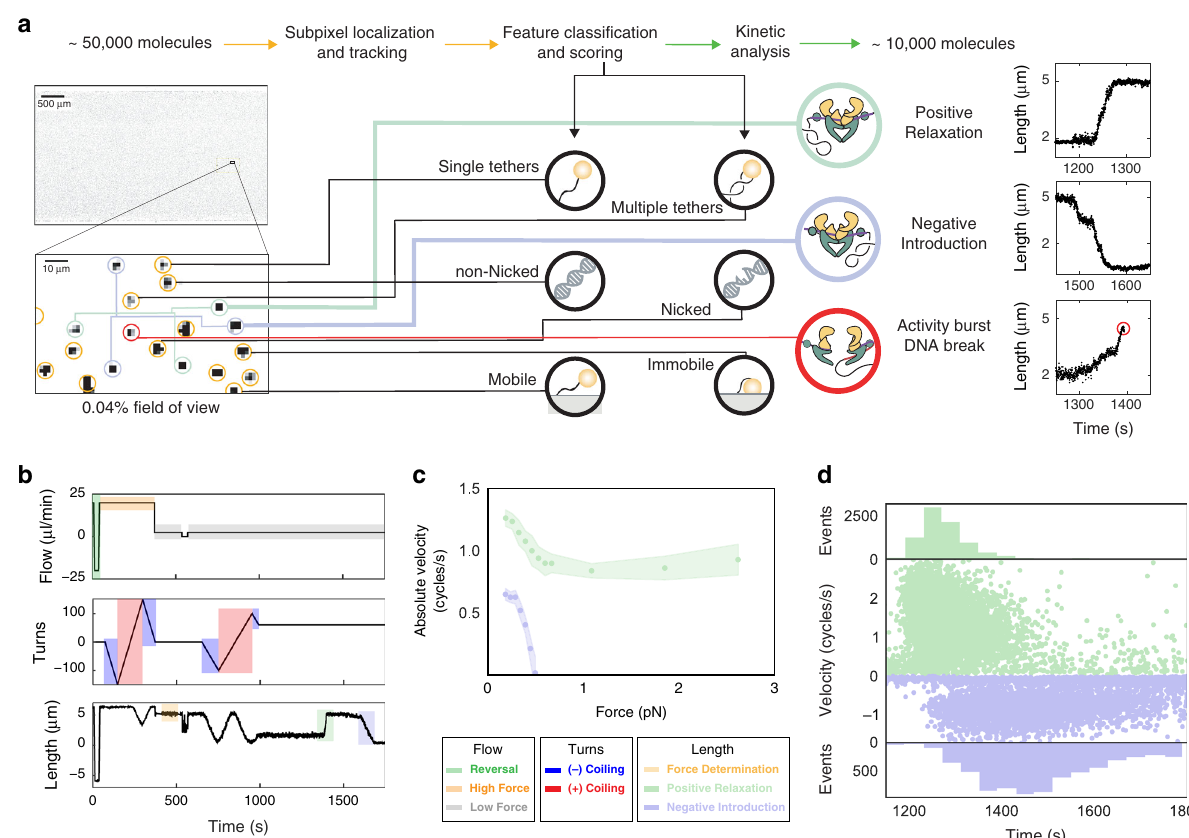
Fig. 4 Massive parallel imaging of DNA supercoiling by gyrase. a Automated feature classi fi cation pipeline to convert raw videos to annotated Molecule Archives containing scores for standard features and tags for gyrase behaviors. Images and example traces were selected from three independent experiments. b Changes in fl ow and magnet rotations used for molecule classi fi cation. Mobility is checked using fl ow reversal (green). Negative and positive coiling are conducted to select singly-tethered beads (blue and red). Force is determined at higher frame rate (33 Hz, orange). Finally, rapid lengthening, pausing, and shortening are observed as gyrase relaxes positive supercoils (green) and introduces negative supercoils (blue). c Velocity (cycles/s) versus force (pN) dependence of gyrase. Median rates of positive supercoil relaxation (green) and negative supercoil introduction (blue) ( n = 680 molecules from two independent experiments). Shaded regions represent the s.e. median. d Gyrase activity burst velocities (cycles/s) versus start times (s) for individual molecules observed in a single experiment. Bursts of positive relaxation (green, n = 8426 bursts from one experiment) and negative introduction (blue, n = 3302 bursts from one experiment). Molecules at higher forces did not have negative supercoil introduction bursts, but were nonetheless plotted and show up as a broad scatter near zero. Of the 53,831 microspheres tracked, 12,172 passed the pipeline outlined and were evaluated for activity